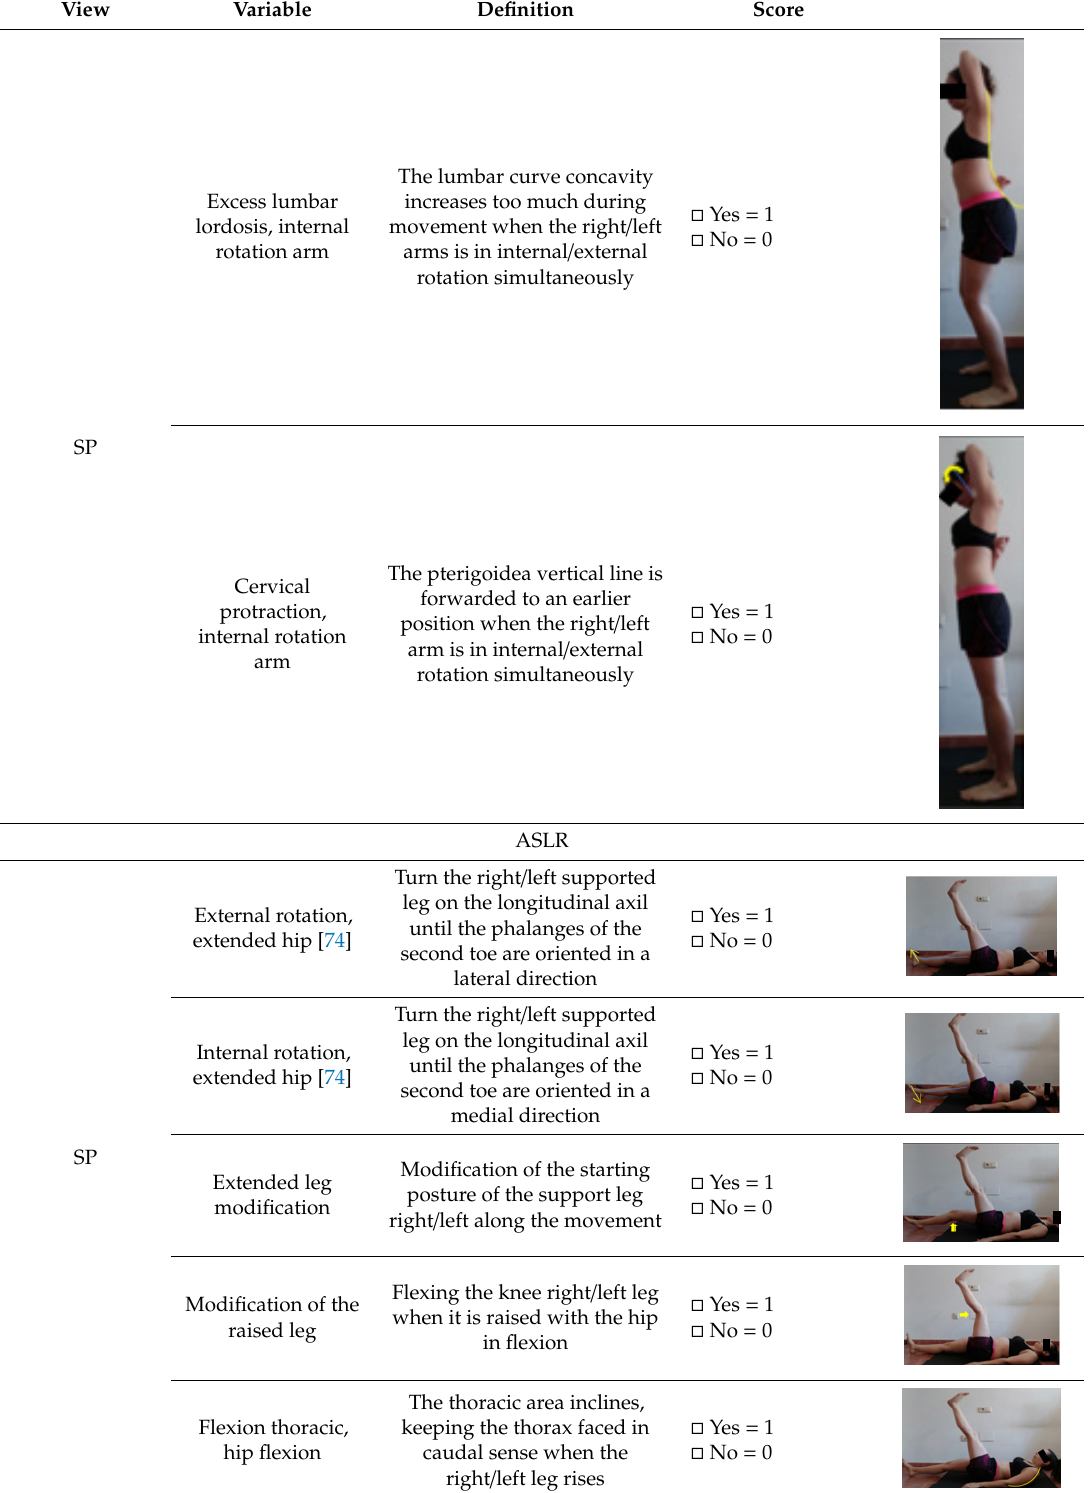
Internal rotation, extended hip